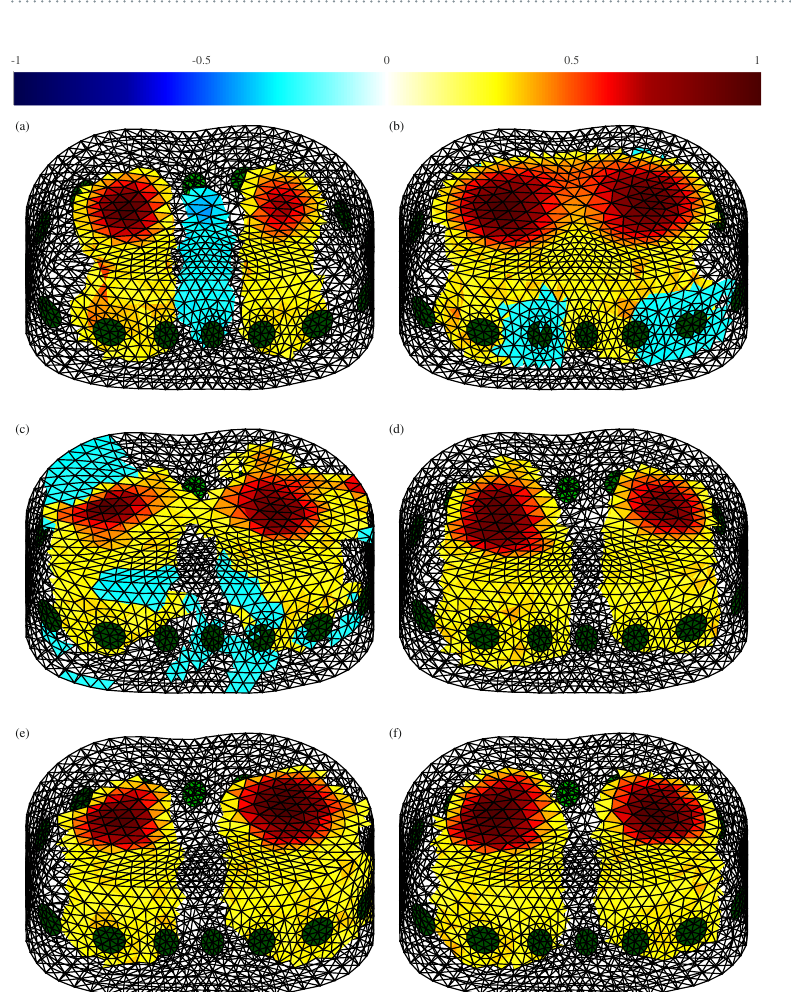
Figure 3. 3D EIT reconstructions of lung data using different methods: ( a ) one-step GN, ( b ) the PDIPM, ( c ) an ANN as inverse solver, trained by considering sources of errors, ( d ) the proposed method, trained by considering errors in measurement data, ( e ) an ANN as inverse solver, trained without considering errors and ( f ) the proposed post-processing method, trained without considering errors. The normalised resistivity distribution is given at the top. The electrodes are shown in